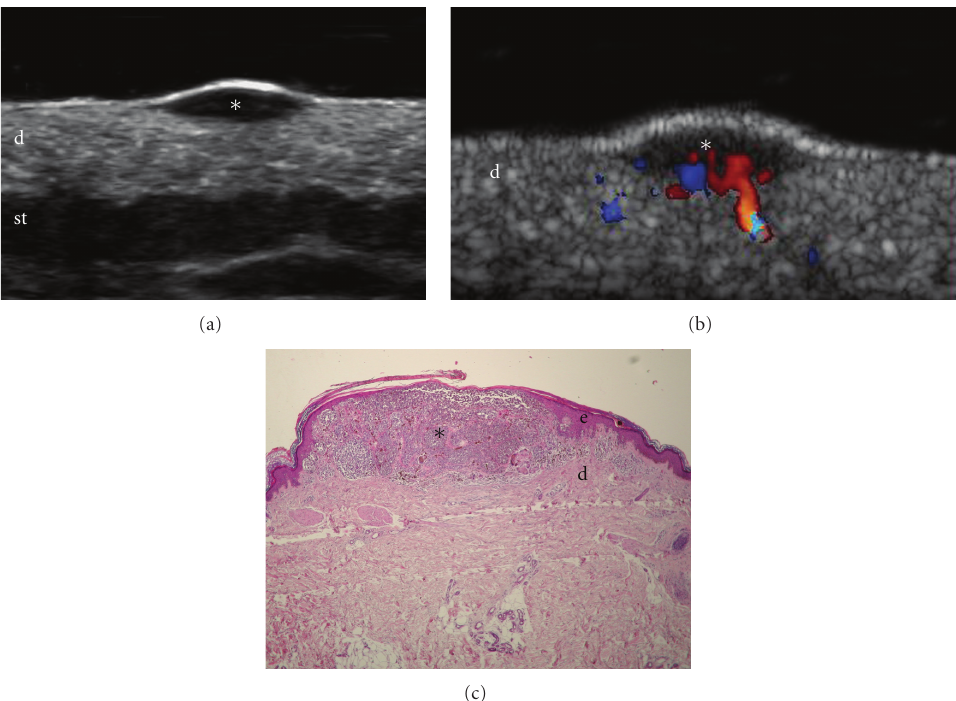
Figure 2: Melanoma primary tumor infiltrating dermis. (a) Ultrasound (grey scale, transverse view, dorsal region) shows oval-shaped hypoechoic lesion ( ∗ ) that involves the dermis. The epidermis also appears more hyperechoic and thickened. (b) Color Doppler ultrasound (transverse view) demonstrates increased blood flow within the tumor that predominates at the bottom of the lesion ( ∗ ). (c) Histology (HE × 4, courtesy of Dr. Laura Carre˜no, Department of Pathology, Hospital Clinico Universidad Chile, University of Chile, Santiago, Chile) demonstrates atypical melanocytic cells infiltrating epidermis and dermis. Prominent vessels are detected in the subtumoral